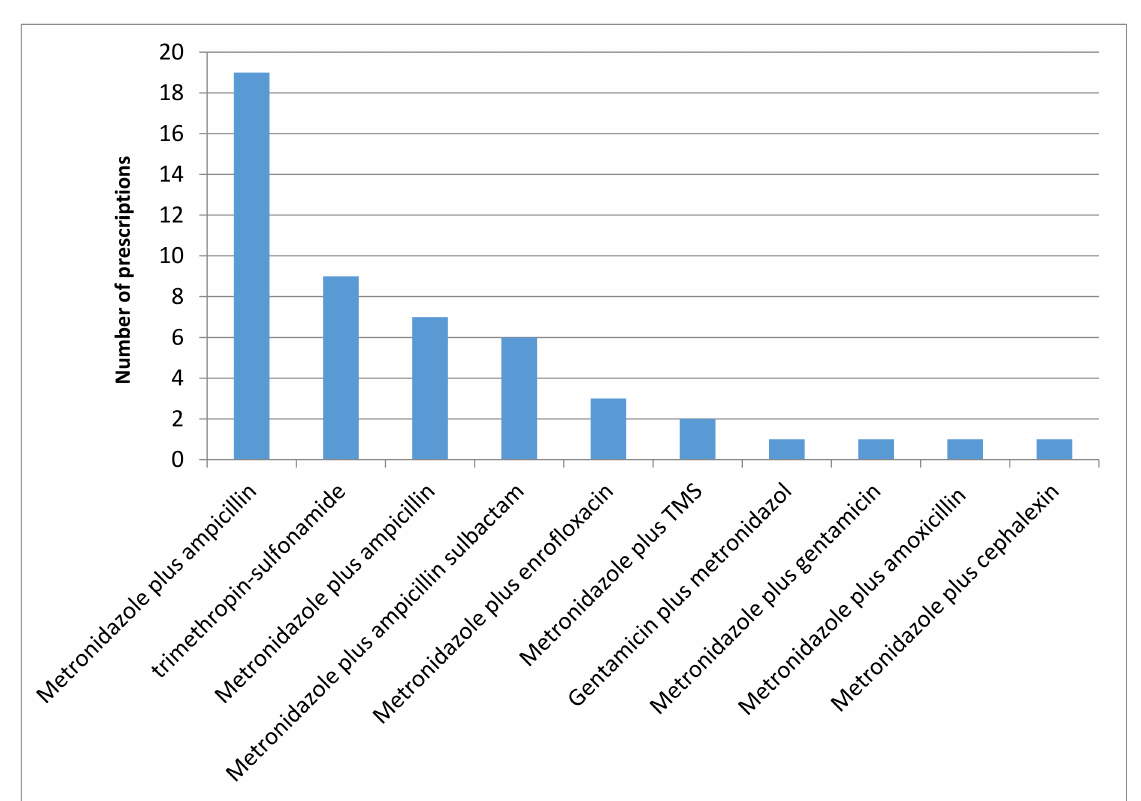
Figure 2. Histogram of the combinations of antimicrobials prescribed for bloody acute gastroenteritis ( n = 50